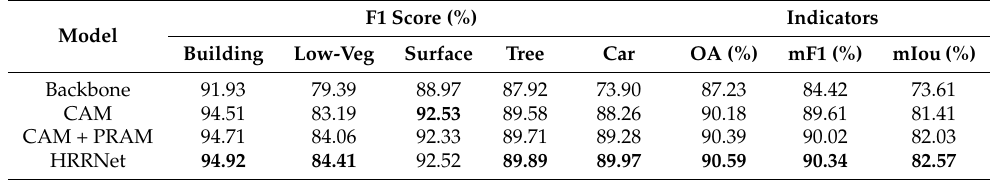
Table 2. Ablation results of the second set (on Vaihingen data set), the optimal results are bolded.